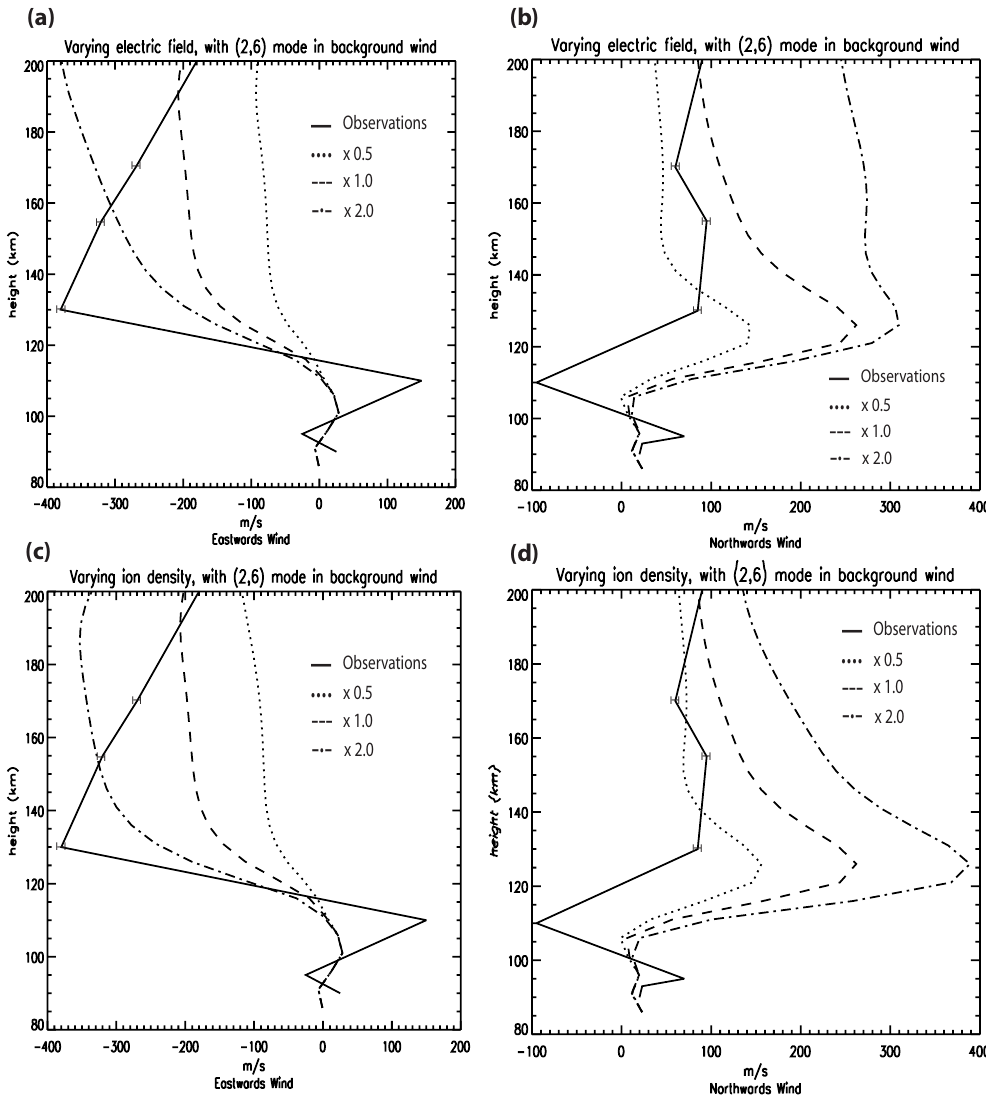
Fig. 9. As Fig. 8, but for the northern trail 28 February observations.